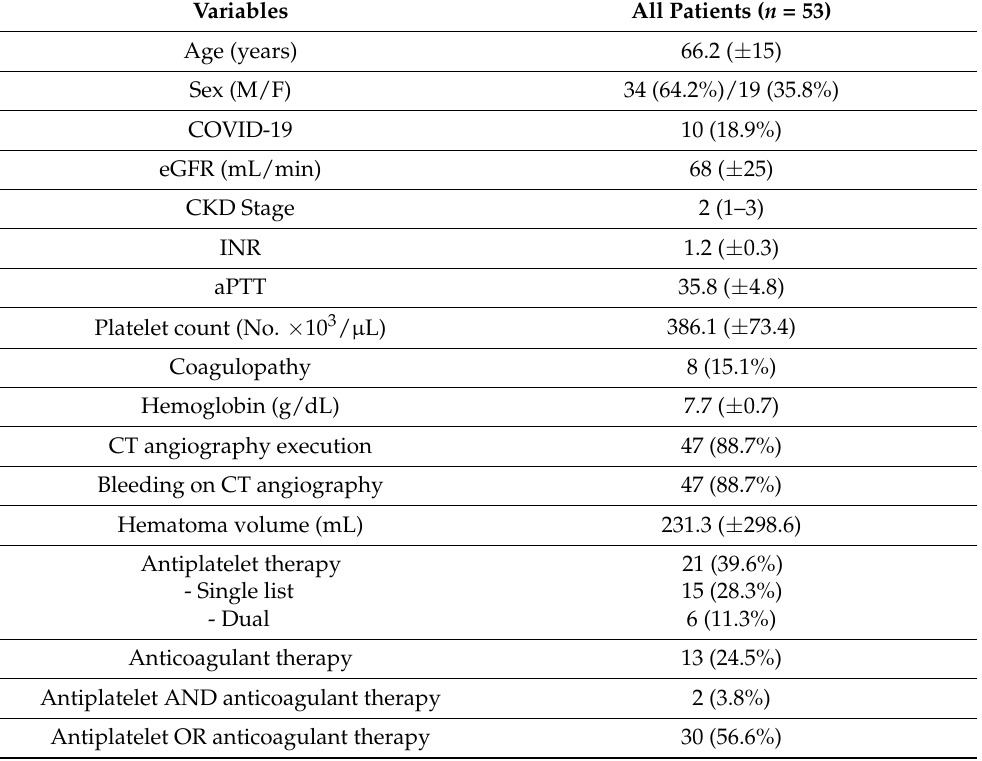
Table 1. Population data.